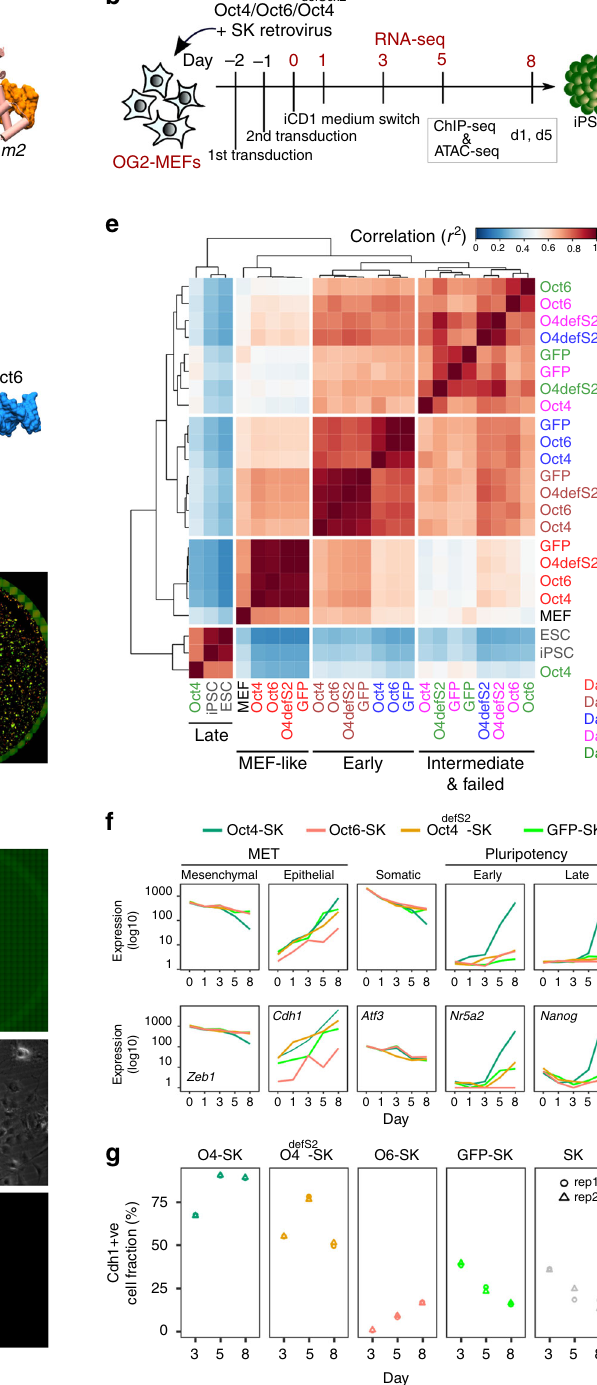
Supplementary Data 1). The upregulated genes in Oct4-SK at day 8 showed gene ontology terms enriched for embryo development, meiosis, blastocyst formation and DNA (de)methylation (Sup- plementary Fig. 2F). The set of genes upregulated by Oct6-SK showed enrichment of terms associated with somatic system development (e.g., circulatory and neuronal systems). Collec- tively, our data suggest that transcriptional responses at early stages of reprogramming do not require Oct4 but the induction of pluripotency genes are crucially dependent on Oct4, and related POU factors cannot substitute for this function. NATURE COMMUNICATIONS| (2019) 10:3477